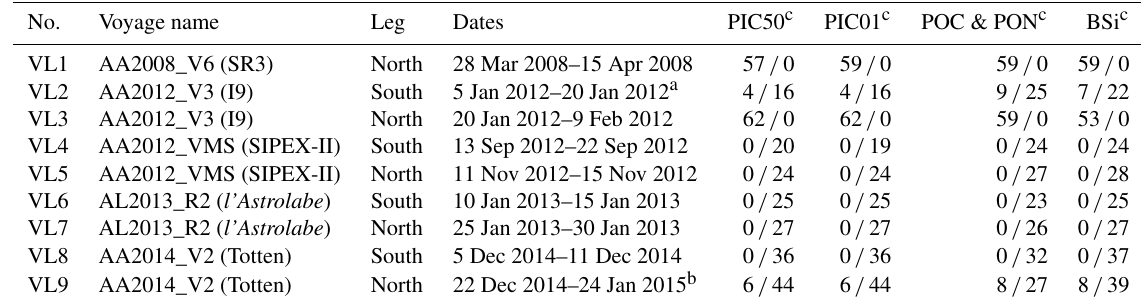
Table 1. Sample collection. SIPEX-II: Sea Ice Physics and Ecosystem eXperiment 2012. No.